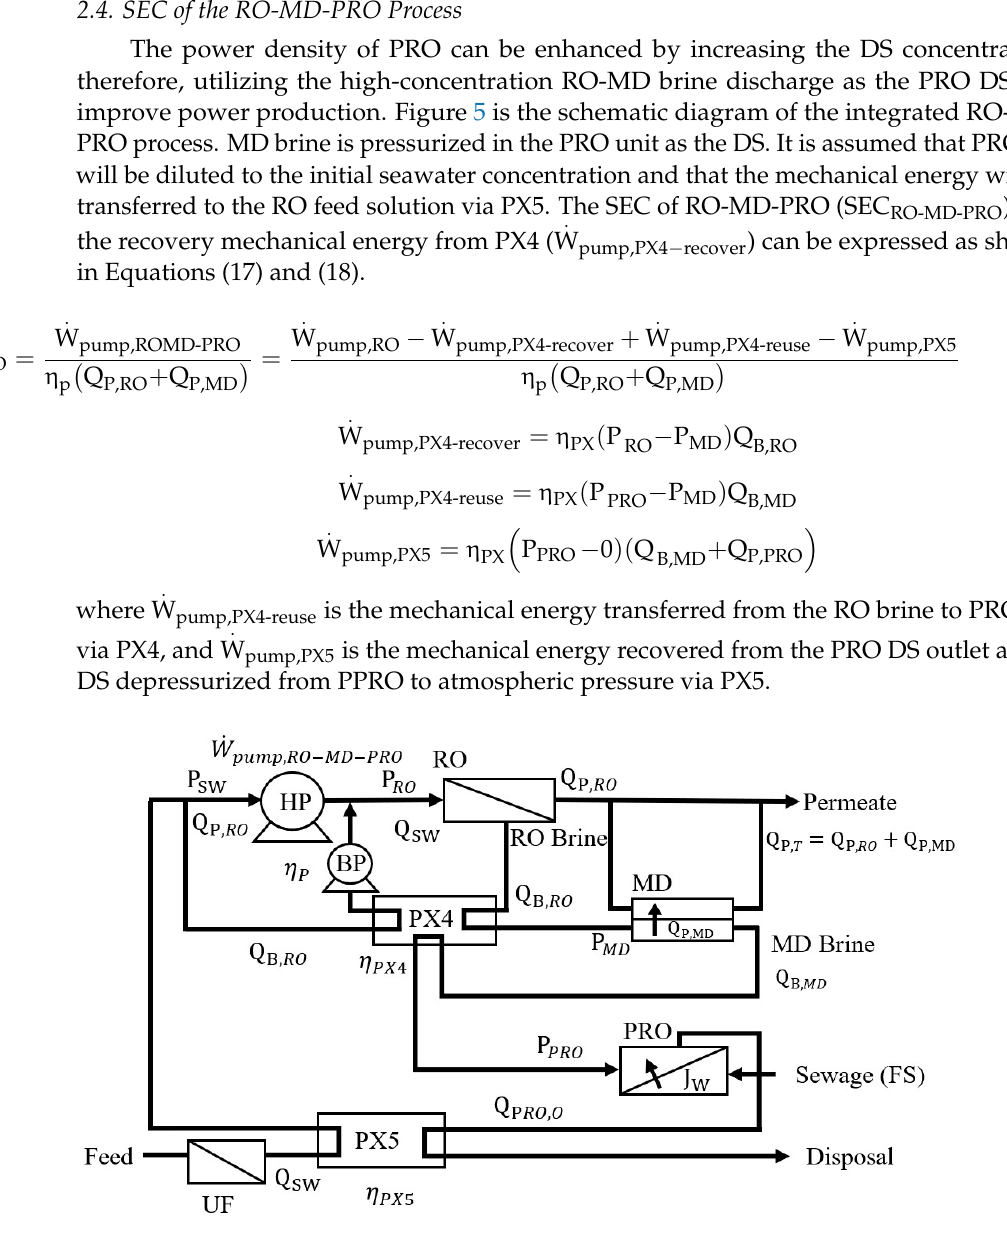
Figure 5. Schematic of the hybrid RO-MD-PRO process.